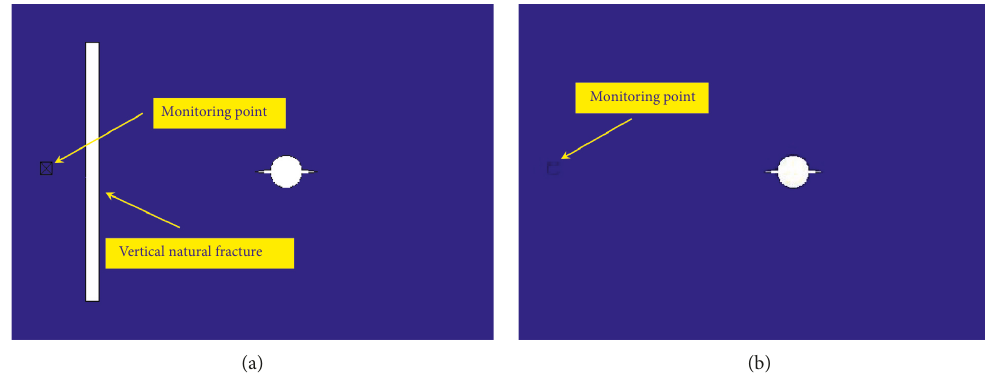
Figure 15: Layout diagram of monitoring points. (a) Case CN